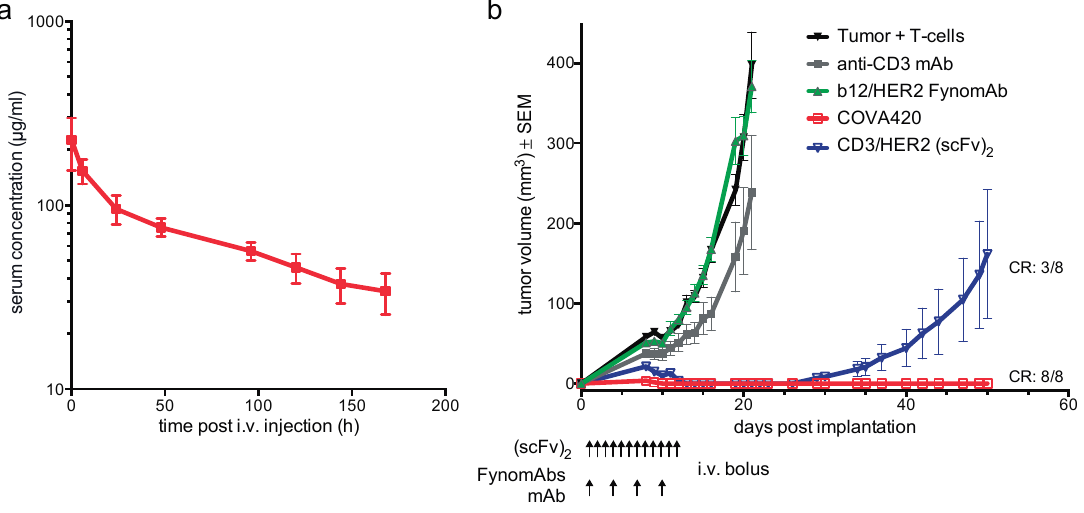
Figure 3. ( a ) Pharmacokinetic analysis of COVA420 in C57BL/6 mice. Results are plotted as mean concentrations ± SD (n = 5). ( b ) Prophylactic SKOV-3 in vivo efficacy model. NOD.CB17 Prkdc mice were treated twice weekly with 0.5 mg/kg vehicle control (black), anti-CD3 mAb (grey), irrelevant FynomAb (green) or COVA420 (red) on days 1, 4, 7 and 10. CD3/HER2 (scFv) 2 (blue) was injected daily at 0.16 mg/kg for 12 days, as indicated by the arrows. Tumor volume (mm 3 ) is shown as mean ± SEM (n = 8); “CR” indicates the fraction of tumor-free mice in the COVA420 and in the CD3/HER2 (scFv) 2 treatment groups on day 50. 2.3. COVA420 Selectively Kills Cells with High HER2 Expression, but Spares Cells